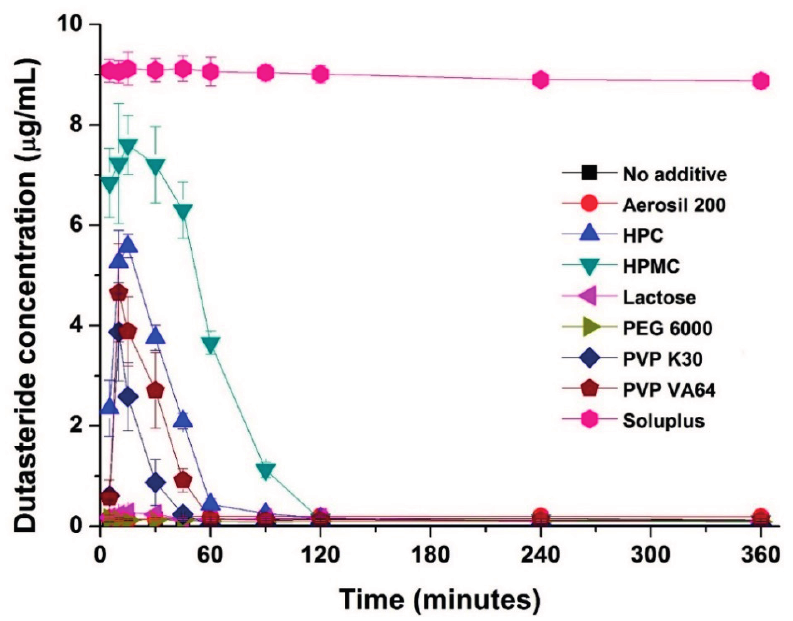
Figure 2. Effect of hydrophilic polymers on dutasteride recrystallization. Data are expressed as the mean ± standard deviation ( n =